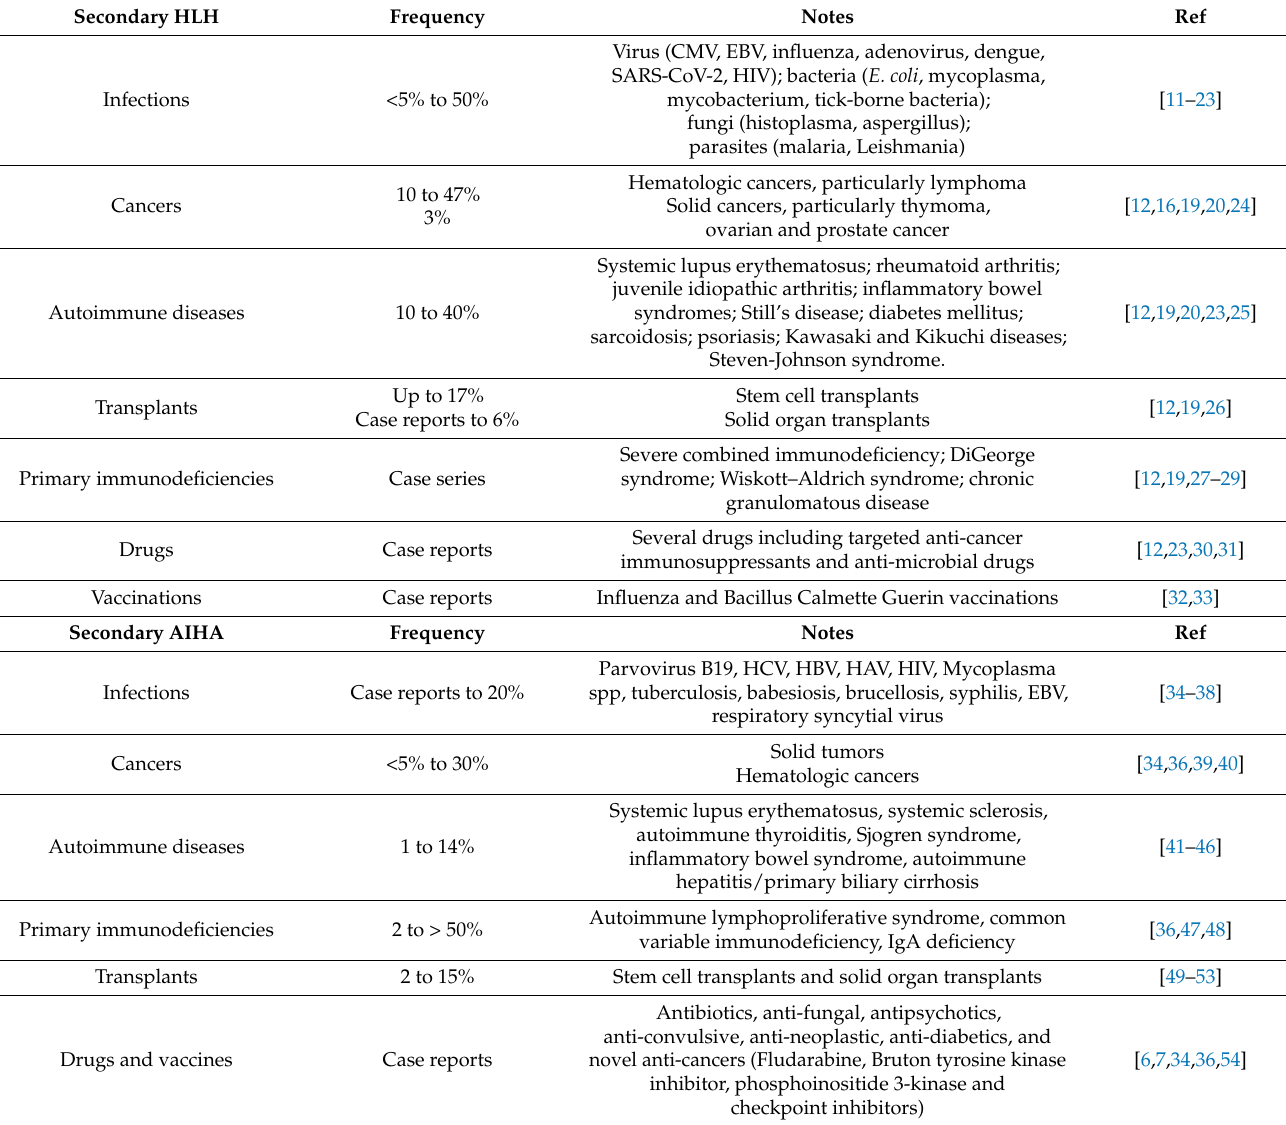
Table 4. Causes of secondary hemophagocytic lymphohystiocytosis (HLH) and autoimmune hemolytic anemia